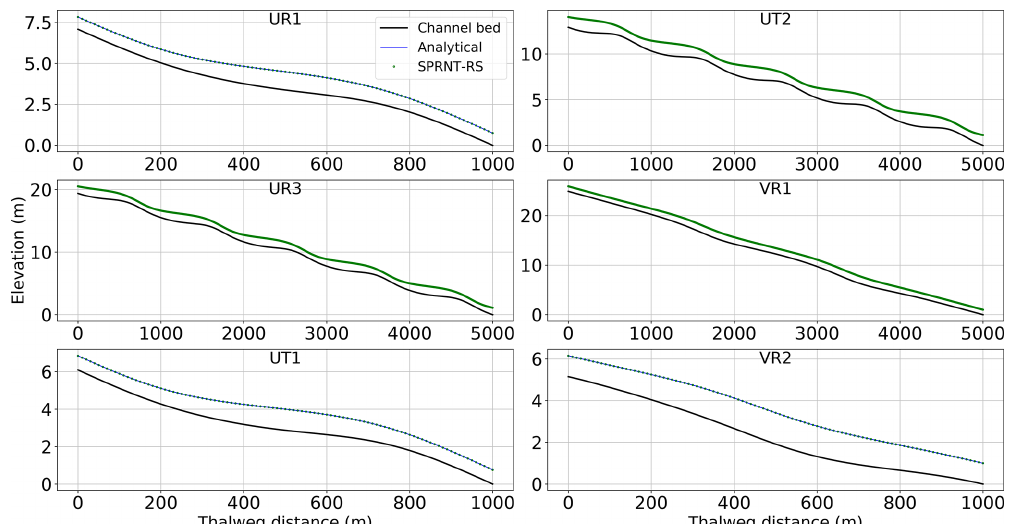
Figure 12. Comparison between simulated water surface elevation from SPRNT-RS and analytical solution for analytical test cases of MacDonald et al. (1995).